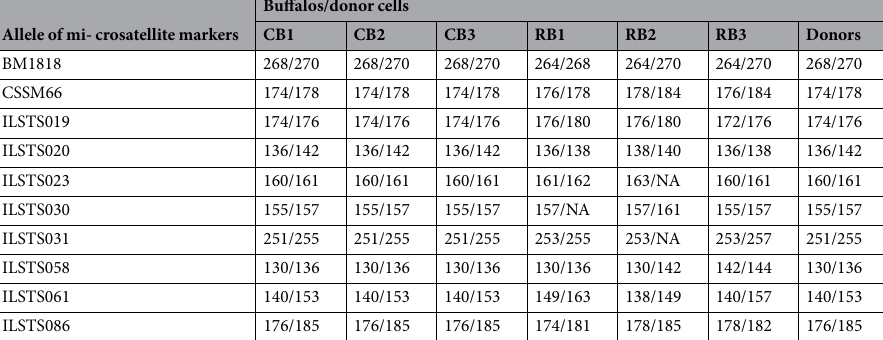
Table 3. Microsatellite analysis of buffalos and donor cells * . * Microsatellite analysis was performed on genomic